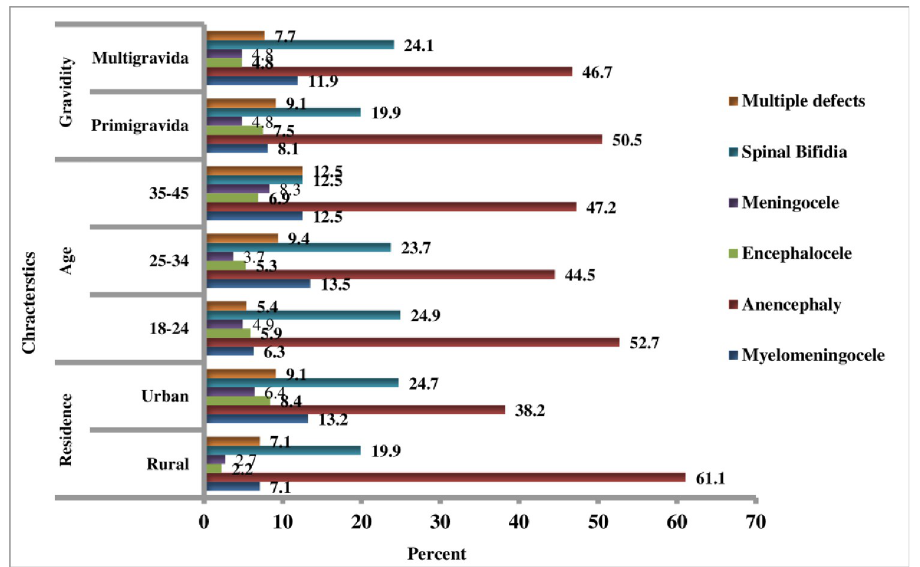
Fig 7. Type of NTDs by residence, maternal age and gravidity, Eastern Ethiopia, data from 2017–19.